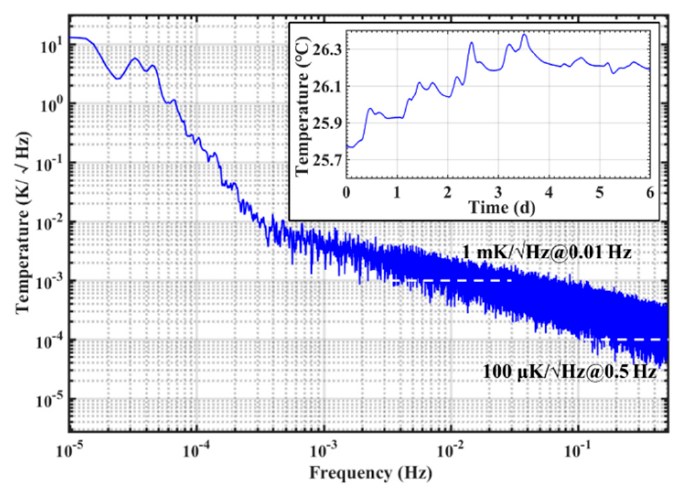
Figure 10. Noise floor test results of the gold-film temperature sensor Chip E-1.